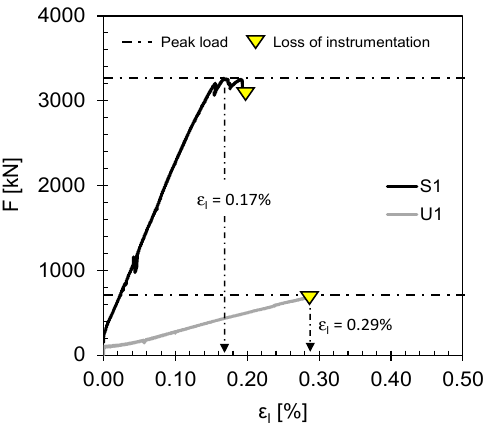
Figure 12. Load–longitudinal deformation (F- ε l ) diagram for the specimens U1 and S1 tested under pure compressive load. σ l